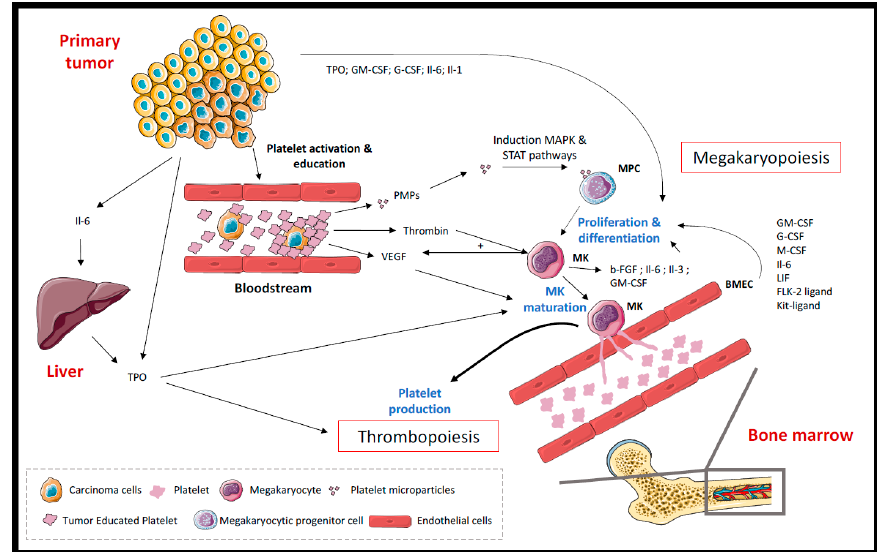
Figure 1. Mechanisms of cancer-associated thrombocytosis. This figure summarizes all the mechanisms involved in the production of platelets mediated by the primary tumor. BMEC: Bone Marrow Endothelial Cells. This figure was obtained using Servier medical art. http://smart.servier.com/. GM-CSF: Granulocyte-